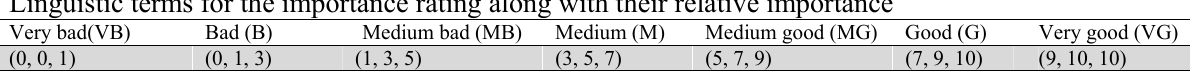
Linguistic terms for the importance rating along with their relative